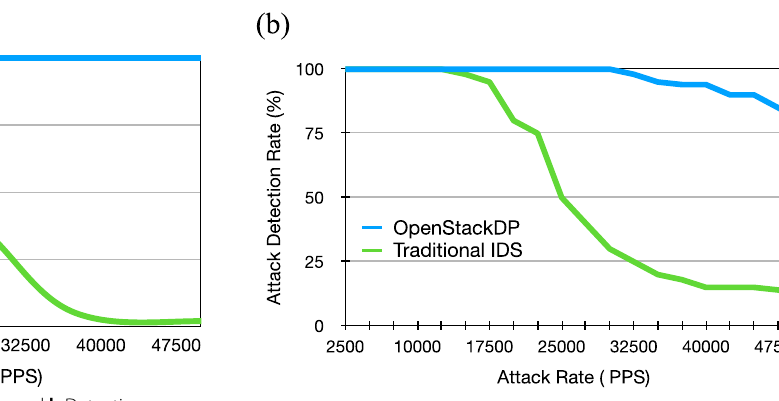
Fig. 20 Performance of Intrusion. a Prevention and b